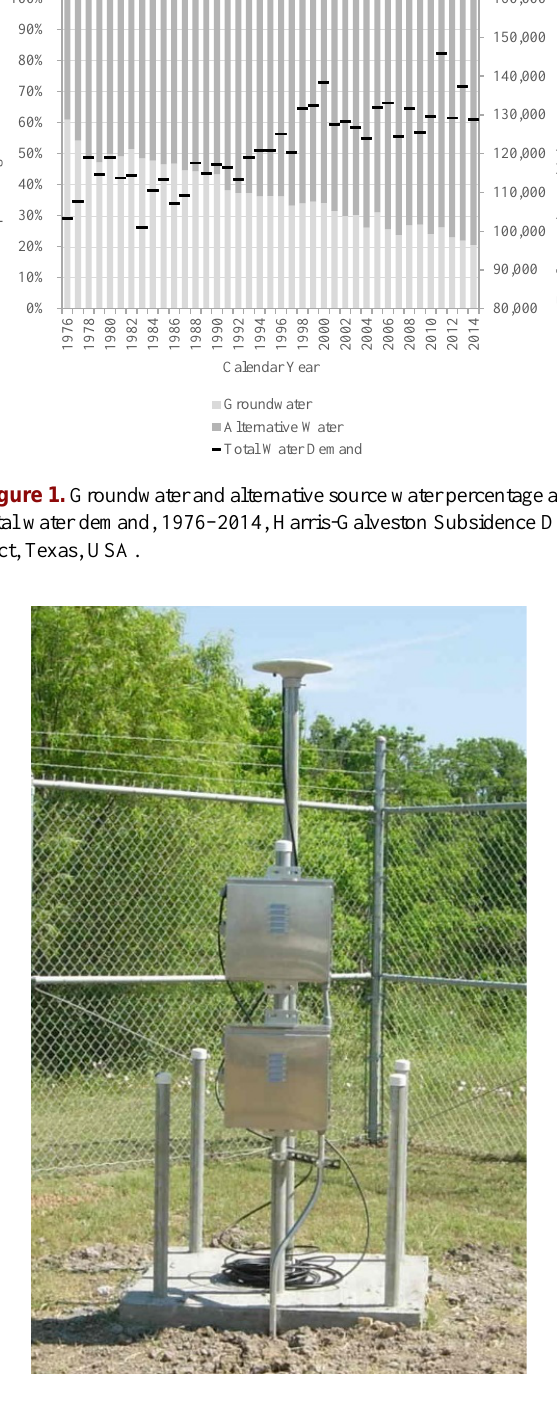
Figure 2. Subsidence monitoring station located near Texas City, TX,